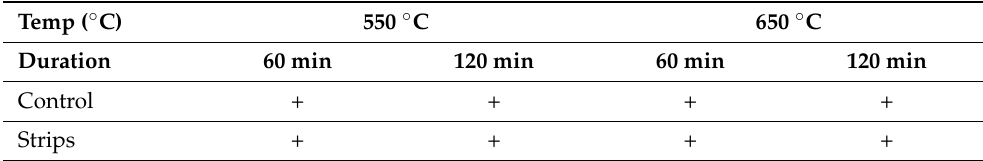
+ indicates growth, and - indicates no